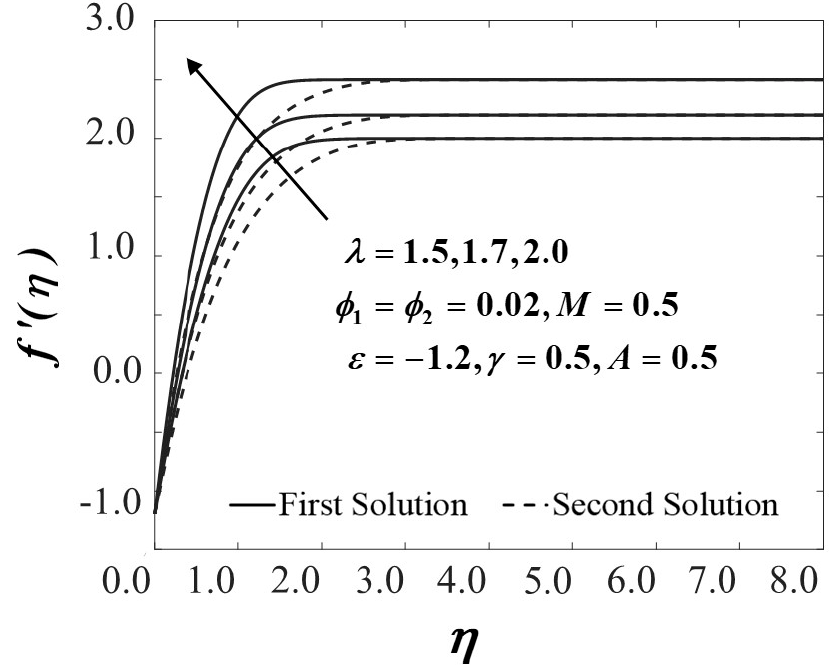
Figure 3. Velocity profiles of f (cid:48) ( η ) for di ff erent values of λ .